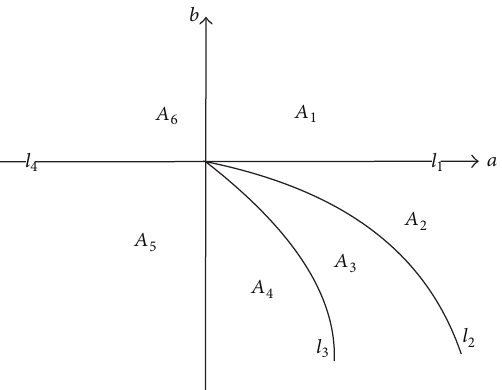
Figure 1: The locations of the regions 𝐴 𝑖 (𝑖 = 1,2,...,6) and curves (𝑖 = 1,2,3,4) 𝑙 𝑖